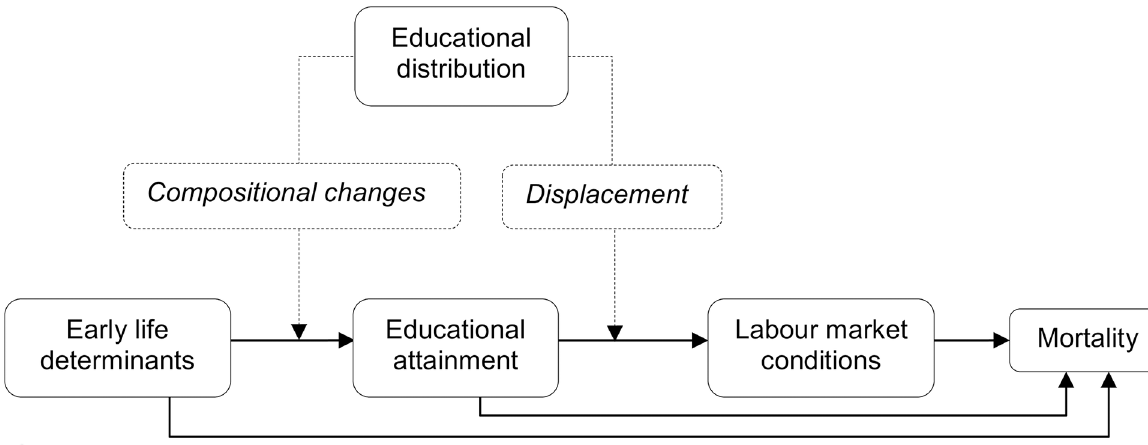
Fig 1. Conceptual model of suggested